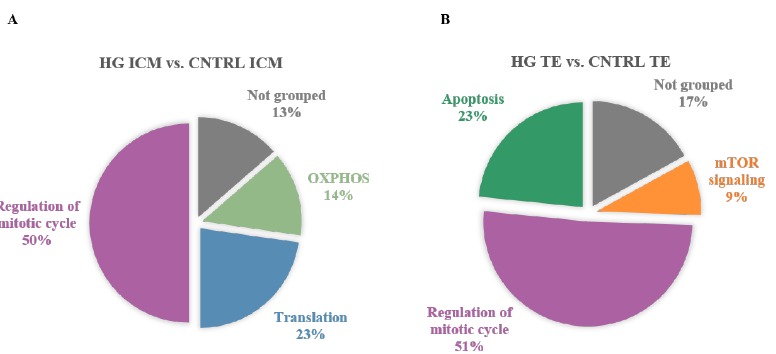
Figure 5. Significantly enriched gene sets (FDR < 0.05) in ICM and TE transcriptomes of in vitro- developed blastocysts with HG compared to CNTRL. Significantly enriched gene sets were identified by GSEA with the Molecular Signature Database (MSigDB) gene set collections: Hallmarks, KEGG, Reactome, and GO BP. GSEA was followed by SUMER analysis for gene set condensation. ( A ). Pie charts showing the enriched gene sets in HG ICM versus CNTRL ICM. ( B ). Pie charts showing the enriched gene sets in HG TE versus CNTRL TE. ICM, inner cell mass. TE, trophectoderm.